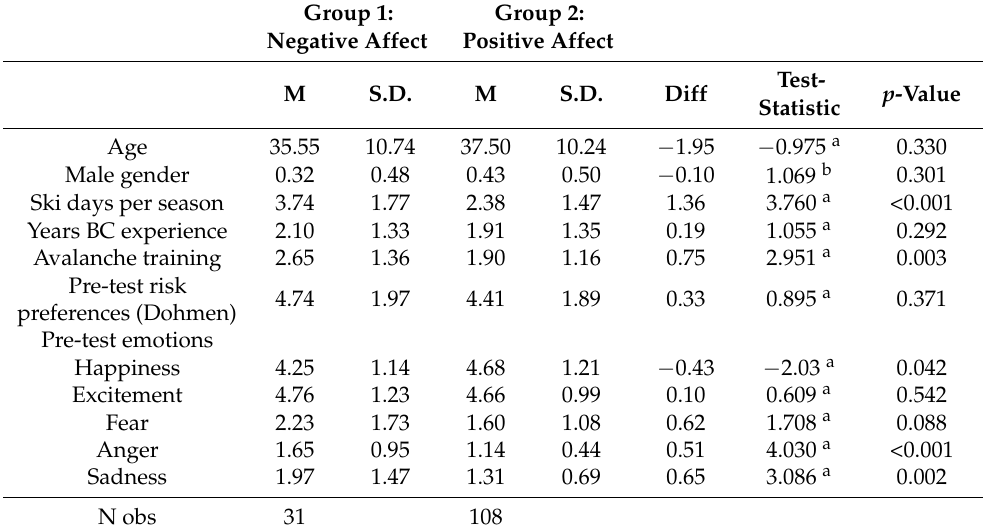
Table 3. Descriptive statistics.